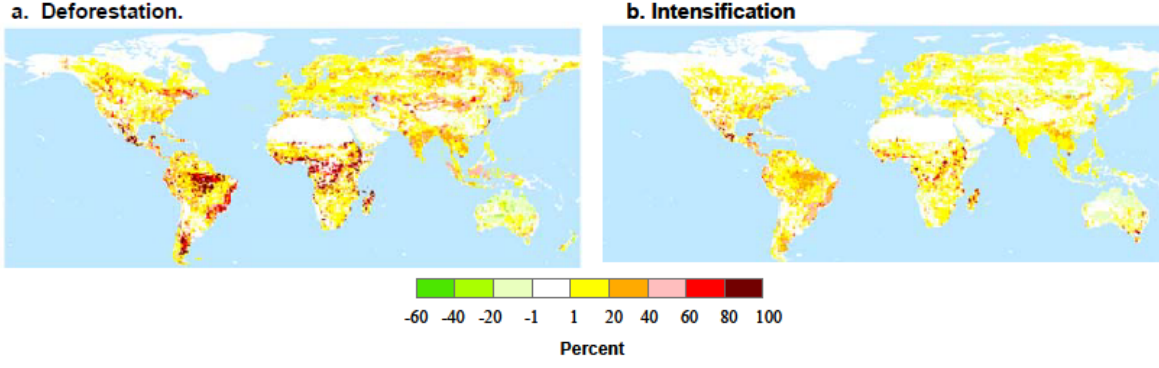
Fig. 5 : The loss of natural areas due to their conversion to crop and pasture agriculture, and cellulosic biofuels between 2000 and 2050, as simulated by the deforestation (a) and intensification (b) scenarios. Source: Melillo and others, 2009, p.